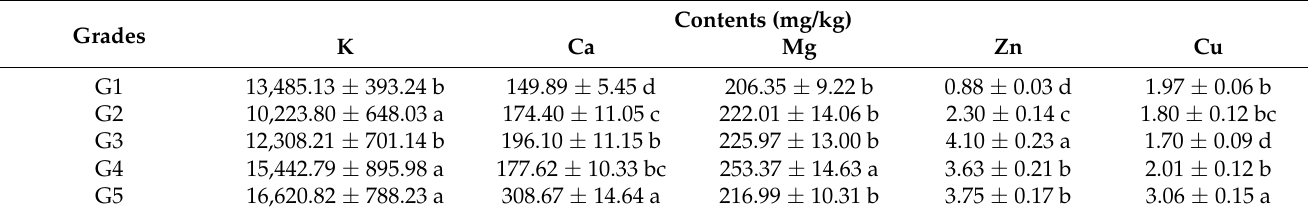
Table 2. The mineral element contents of dried jujube.